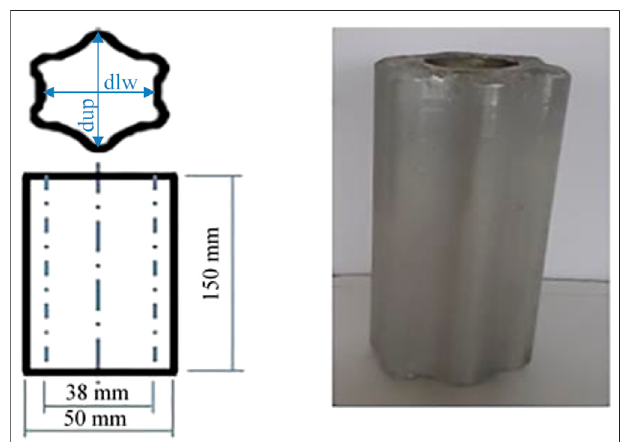
FIGURE 1 | Photograph and schematic diagram of